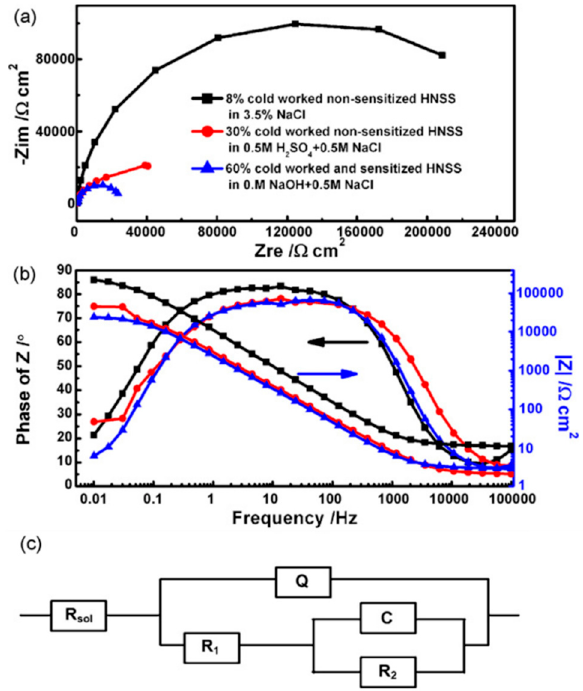
Figure 18. Fe-15Mn-18Cr-2Mo-0.7N-0.04C in 3.5 wt.% NaCl: ( a ) Nyquist plot, ( b ) bode plot, and ( c ) electrical equivalent circuit used to fit impedance data [122]. (Reproduced with permission from refs. [122]. Copyright (2009), Elsevier).